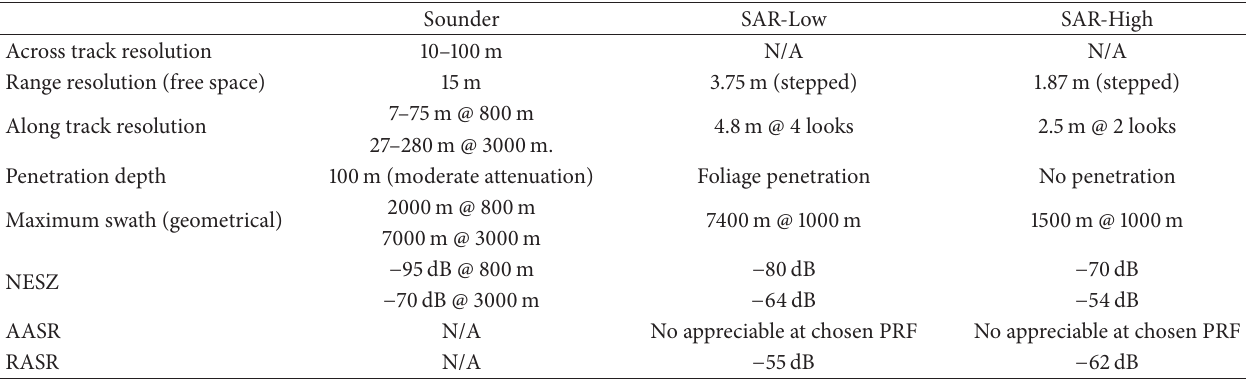
Table 3: Nominal